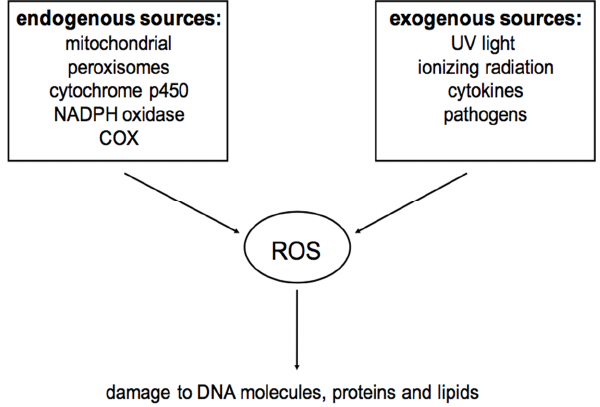
Figure 1. Sources of reactive oxygen species (ROS) (referred to [21]).